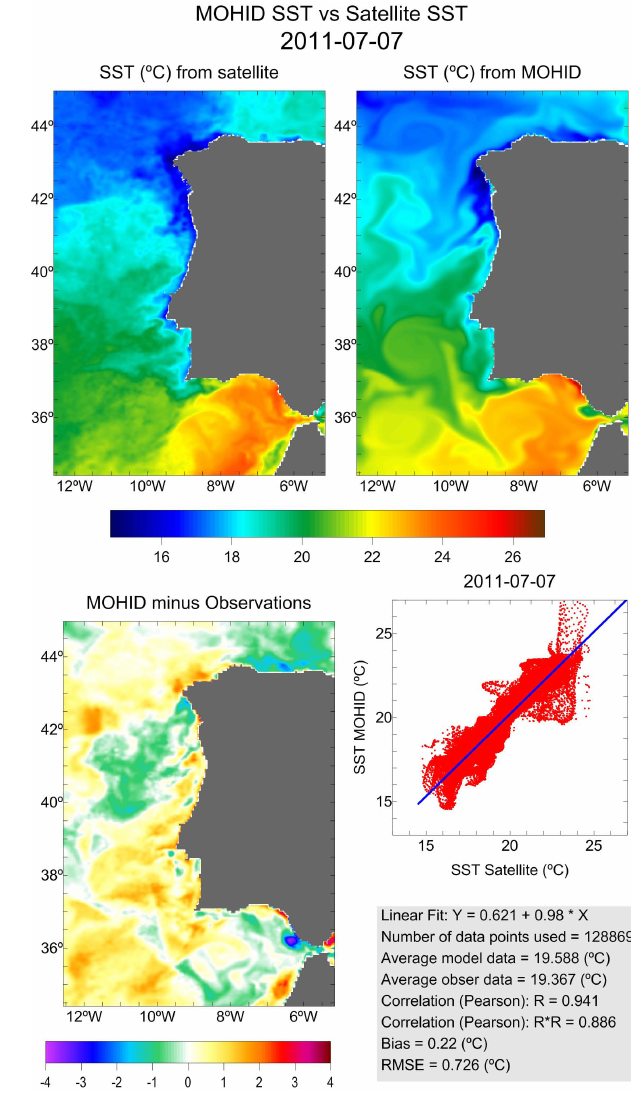
Fig. 8. Sea surface temperature (SST) maps on 25 February 2011 retrieved from remote sensing data (upper left panel), simulated by the model (upper right panel), and their difference (lower pannel). Linear fit between model and data, and results from basic statistical analysis are also shown.